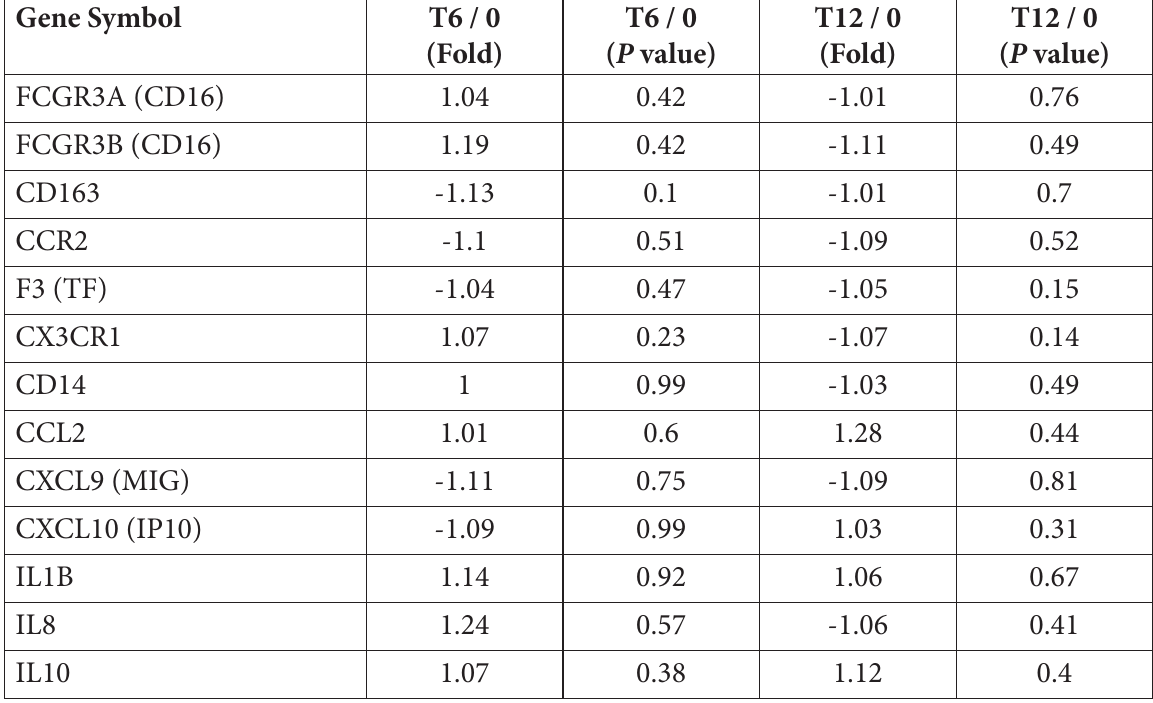
Table 6. Fold change in monocyte genes of a priori interest following 6 and 12 weeks of ator- vastatin treatment